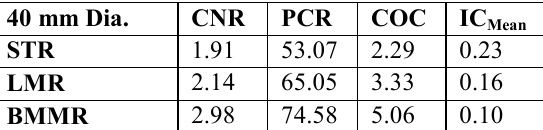
Fig .10: Conductivity reconstruction of the phantom with inhomogeneity (D = 40 mm, L = 37.5 mm) near electrode No.-3 ( λ = 0.0001 ): (a) original object, (b) image with STR, (c) image with LMR, (d) image with BMMR. Table-6: CNR, PCR and COC of the cond uctivity images of Fig. -10 40 mm